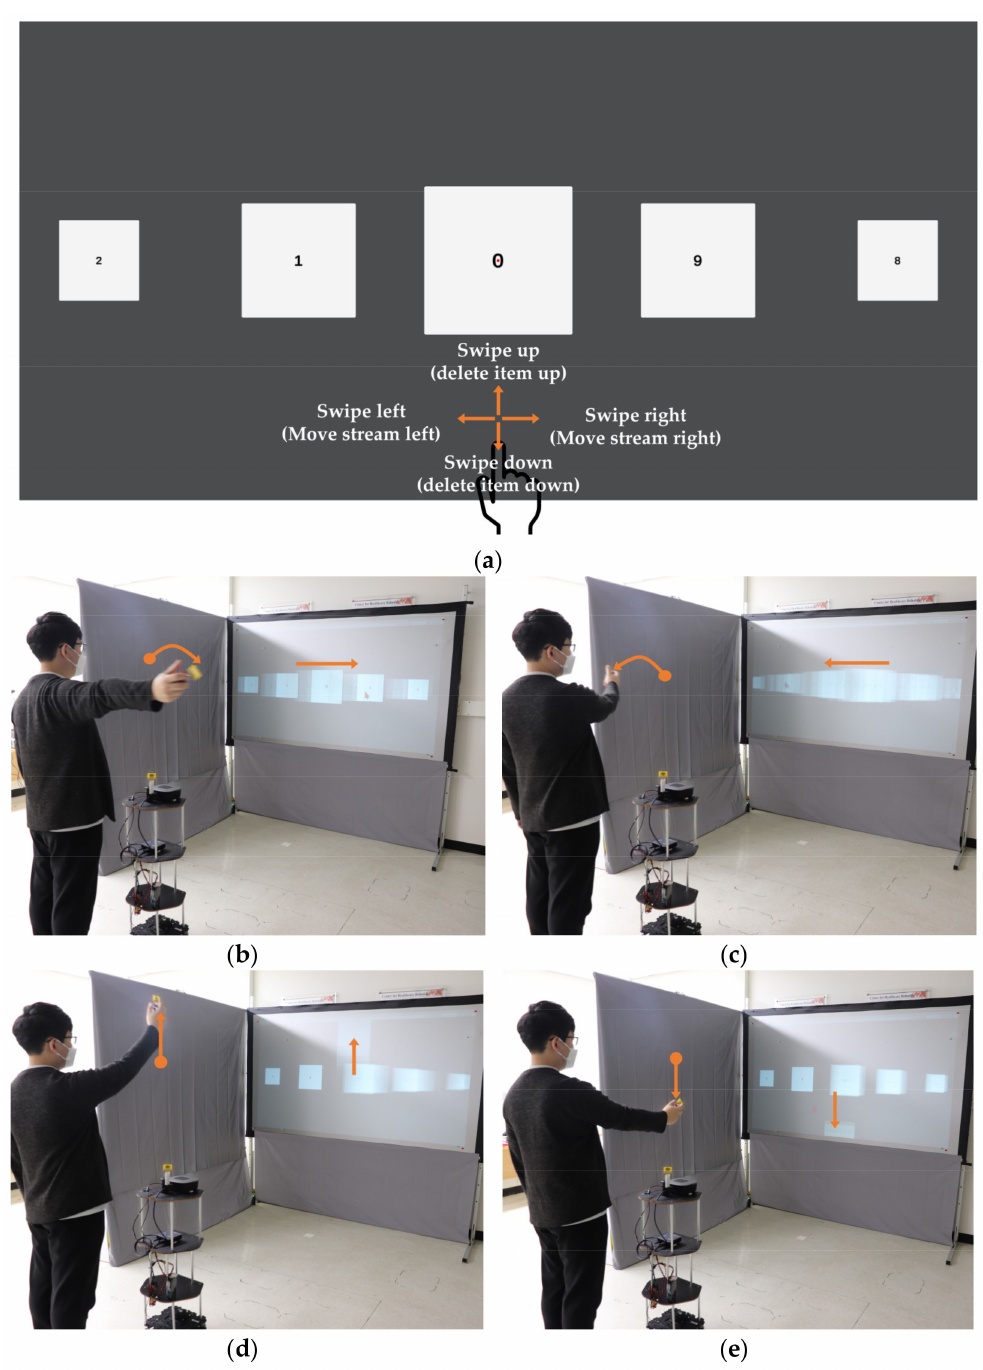
Figure 11. Mid-air UWB-based hand gestures to manipulate projected items: ( a ) A stream of num- bered blocks, ( b ) swiping right, ( c ) swiping left, ( d ) swiping up, and ( e ) swiping